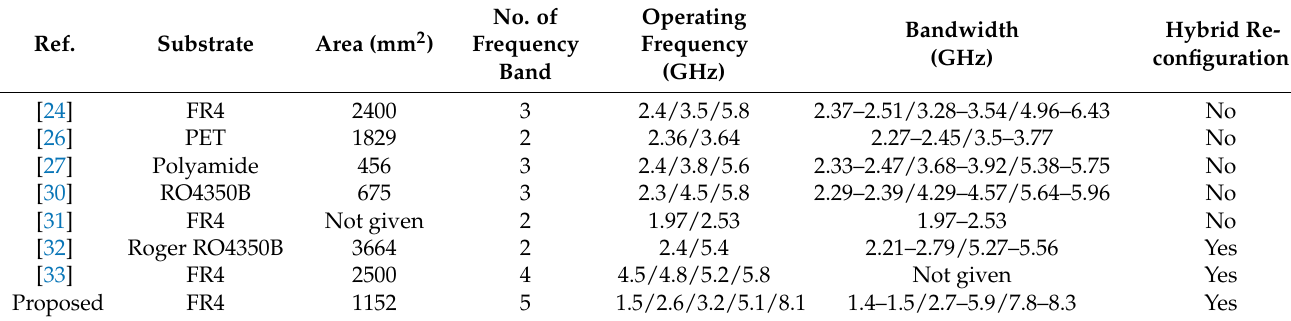
Table 4. Comparative analysis for proposed